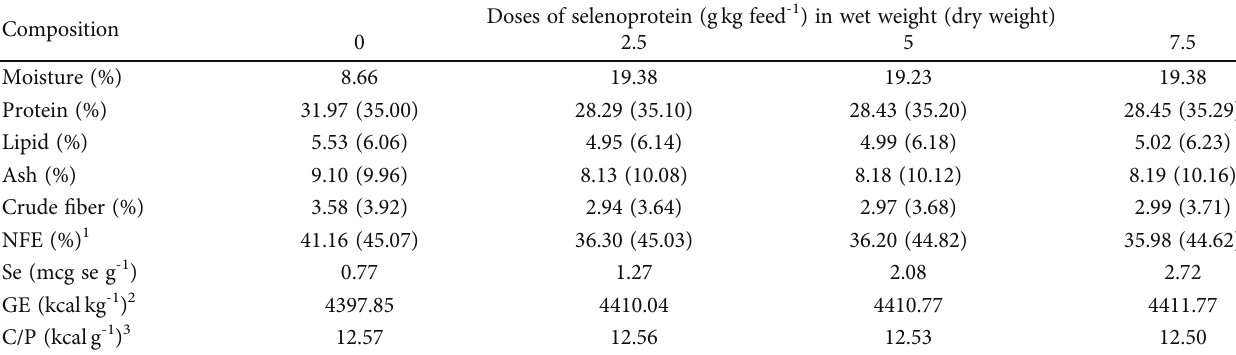
Table 1: Results of proximate analysis and selenium analysis of test